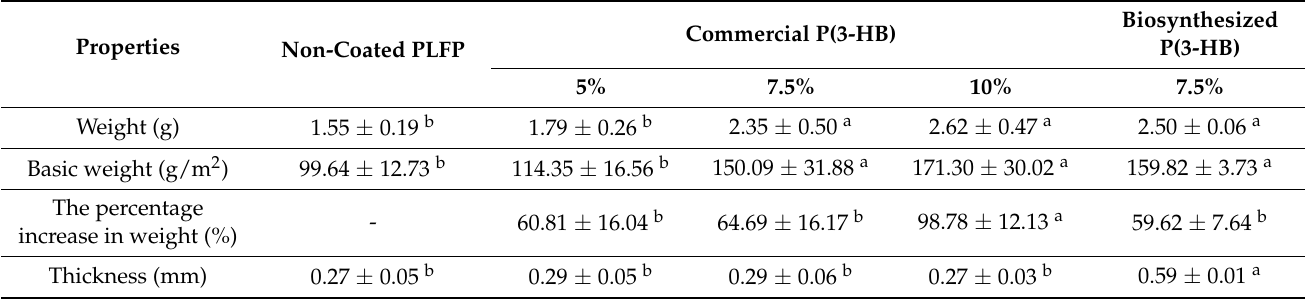
Table 2. Physical properties of the non-coated PLFP, the commercial P(3-HB) coated PLFPs at 5, 7.5 and 10% ( w / v ) and the biosynthesized P(3-HB) coated PLFP at 7.5% ( w / v ).